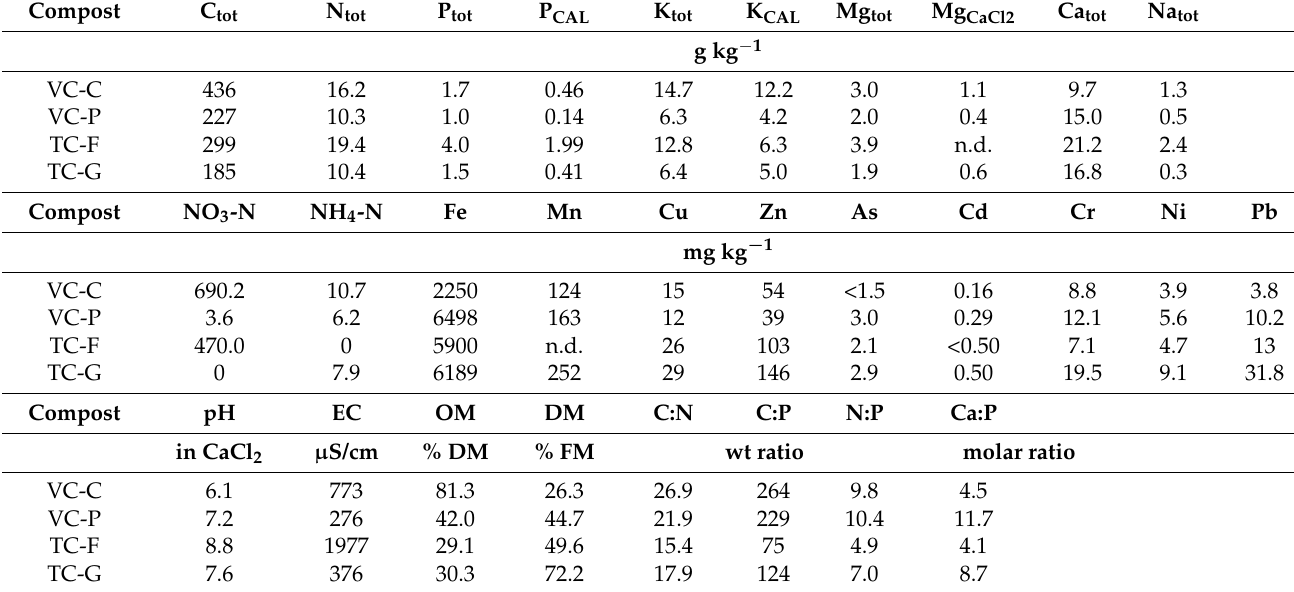
Table 2. Physicochemical characteristics and composition of the studied composts. All values refer to DM contents. As 100 g DM of organic fertilizer were applied per pot, 1/10 of the values equals the nutrient supply per plant in this experiment. CAL denotes elements extracted by calcium acetate/lactate; DM, dry matter; EC, electric conductivity; FM, fresh matter; n.d., not determined; OM, organic